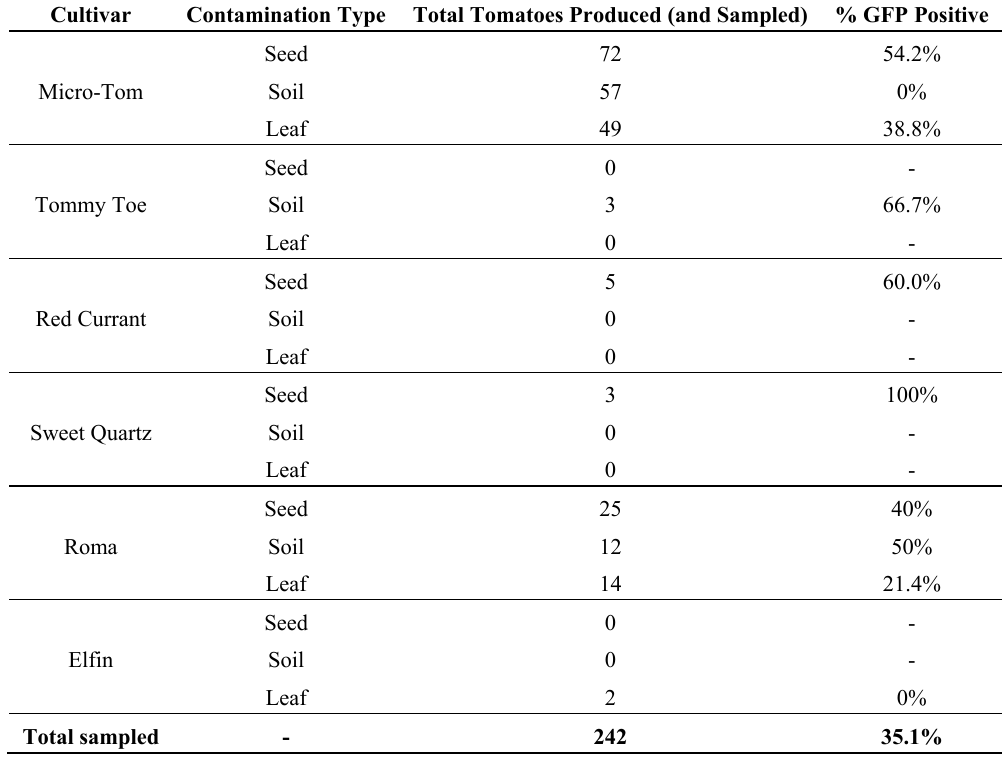
Table 1. Total number of tomatoes produced by and sampled from five plants of each tomato cultivar that had been contaminated (seed, soil, or leaf) with E. coli O157:H7-GFP, and the percent positive for GFP following PCR